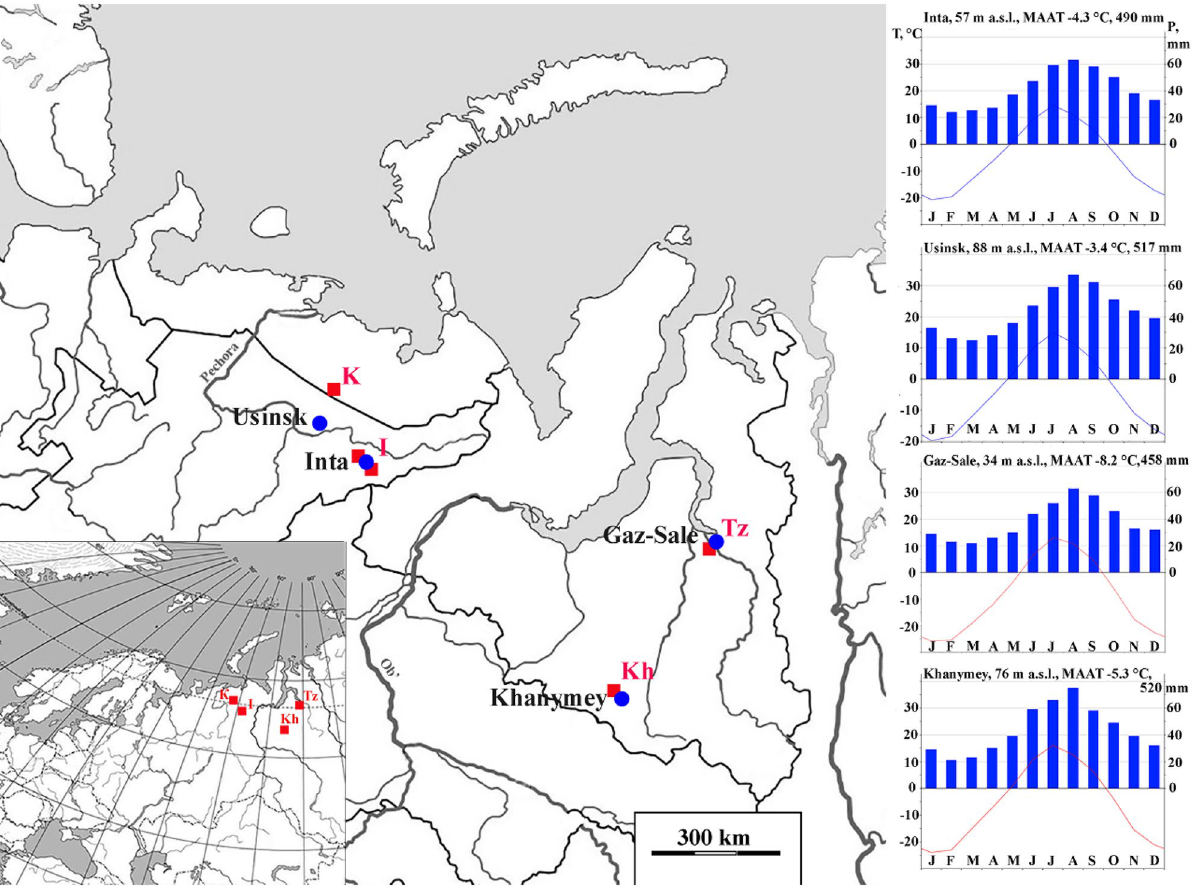
Figure 1. Map showing the location of the sampling study sites (indicated by red squares). The closest climate stations indicated by blue circles. Monthly air temperatures and precipitation based on the climate database https:// ru. clima te- data.